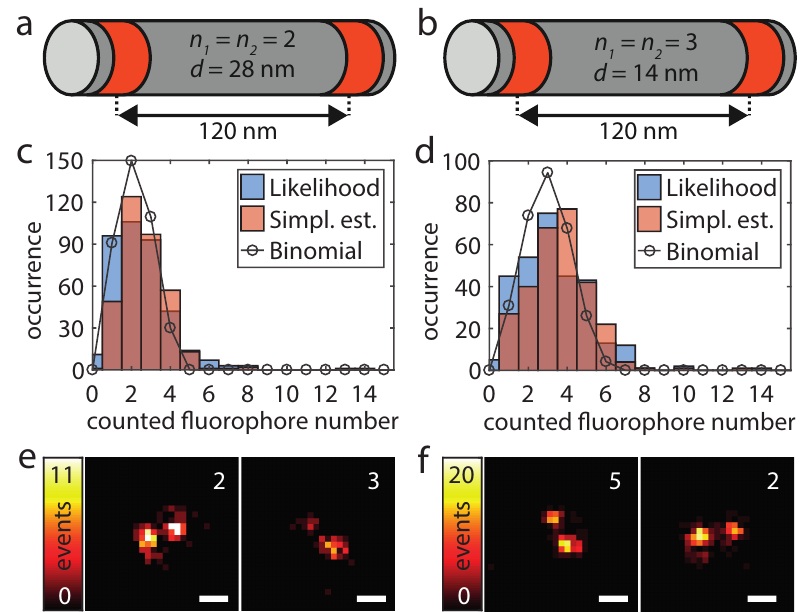
Figure 4. Design ( a , b ), dye molecule numbers ( c , d ) and superresolution imaging ( e , f ) for origami structures exhibiting 4 ( a , c , e ) and 6 ( b , d , f ) labeling positions. ( a , b ) The origami structures feature two marked areas (red), in which there are n 1 and n 2 labeling positions, respectively, at a nearest neighbor distance d . ( c , d ) The blue and the red histograms show the results of the pseudo log-likelihood and the simplified estimator respectively. The black circles correspond to the conditional binomial distribution with ( p = 0.52, n = 4) and ( p = 0.49, n = 6). The parameter p was in both cases estimated by fitting a binomial model to the histogram of the pseudo log-likelihood estimates. ( e , f ) For both origami designs, two super-resolved images of representative origami structures as well as the determined number of dye molecules of the pseudo log-likelihood estimator are shown. Scale bars 100